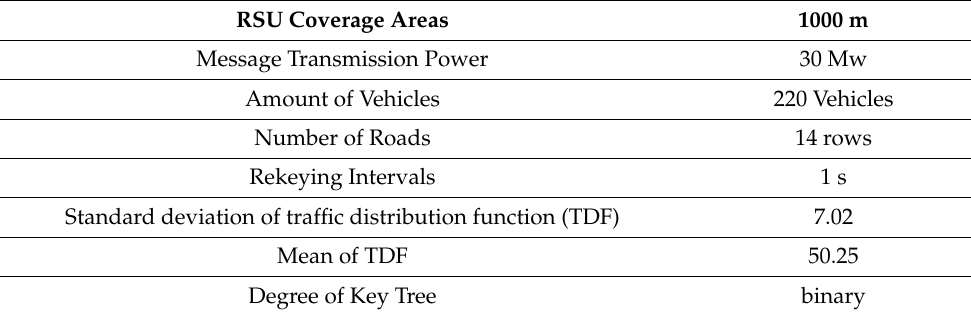
Table 4. Parameters estimated during a probability-based